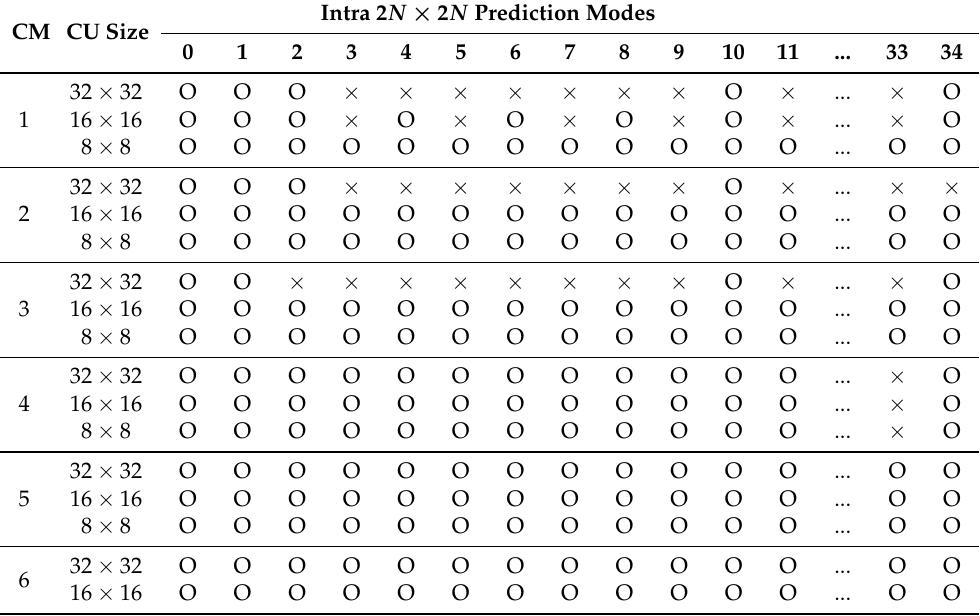
Table 10 represents examples of intra 2 N × 2 N prediction modes of 32 × 32, 16 × 16, and 8 × 8 CUs in HEVC encoder’s descriptor. The CTU size of all camera models used in the experiments was equal to 32 × 32. The minimum CU size of one of the camera models is 16 × 16, and the minimum CU size of the other camera models is 8 × 8. Since DC and planar prediction modes in intra 2 N × 2 N prediction (mode 0 and 1) are very important, these modes are commonly utilized in all CUs of 32 × 32, 16 × 16, and 8 × 8 in all camera models. Camera model 1 uses all angular prediction modes in only 8 × 8 CU. It considers subsets of angular prediction modes for 32 × 32 and 16 × 16 CUs. Mode2, mode10, mode18, mode26, and mode34 are used in 32 × 32 CU. Only angular prediction modes with even indices are considered in 16 × 16 CU. Camera model 2 implemented a subset of intra prediction modes in 32 × 32 CU and a full set of intra prediction modes in 16 × 16 and 8 × 8 CUs. Intra 2 N × 2 N prediction descriptors for Camera models 2 and 3 are identical except for mode 34 in 32 × 32 CU. Although we performed a lot of experiments, videos shot with Camera model 4 did not include mode 33, regardless of the CU size. Camera model 5 supports the full intra 2 N × 2 N prediction modes. Camera model 6, whose minimum CU size is 16 × 16, also supports the full intra 2 N × 2 N prediction modes. Since the hardware logic to perform intra 2 N × 2 N predicted for a large block, such as 32 × 32 and 16 × 16, is expensive, it is expected that the implementation of a limited number of intra 2 N × 2 N prediction modes is preferred in some hardware video encoders. Table 10. Example of intra 2 N × 2 N prediction modes of 32 × 32, 16 × 16, and 8 × 8 CUs in HEVC encoder’s descriptor. CM stands for camera model. Here, O and × represent ‘used’ and ‘not used’, respectively.